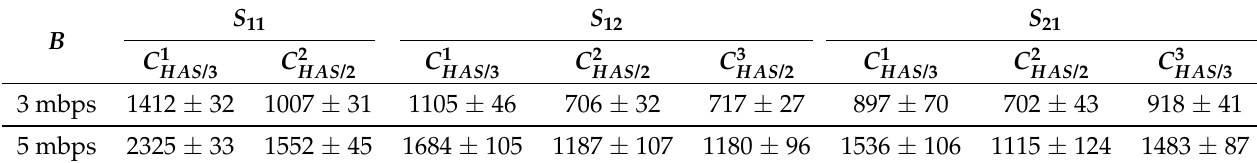
Table 2. The average bitrate r (kbps) of each client running the general ABR.